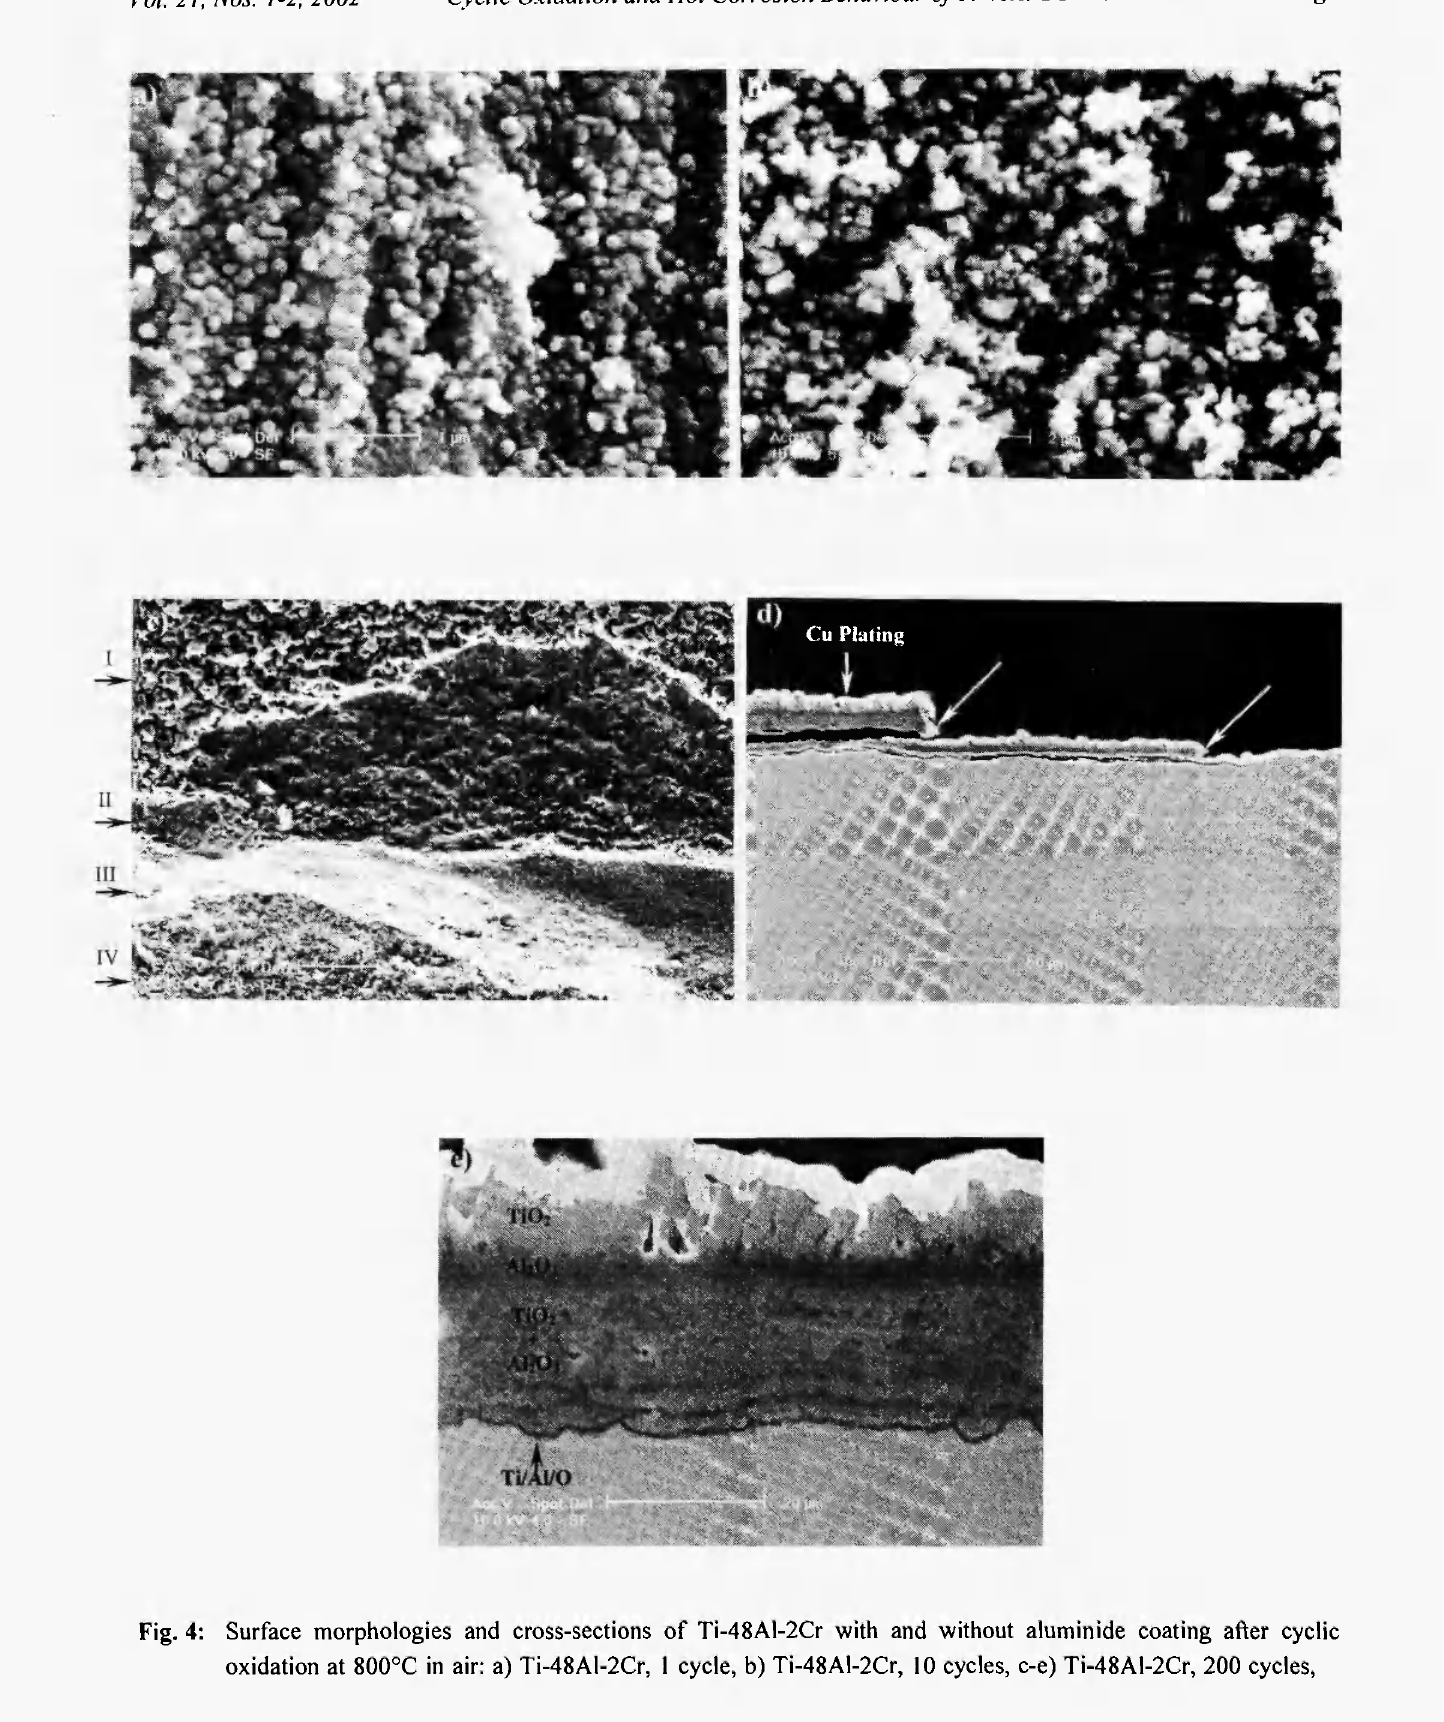
Fig. 4: Surface morphologies and cross-sections of Ti-48Al-2Cr with and without aluminide coating after cyclic oxidation at 800°C in air: a) Ti-48AI-2Cr, 1 cycle, b) Ti-48Al-2Cr, 10 cycles, c-e) Ti-48Al-2Cr, 200